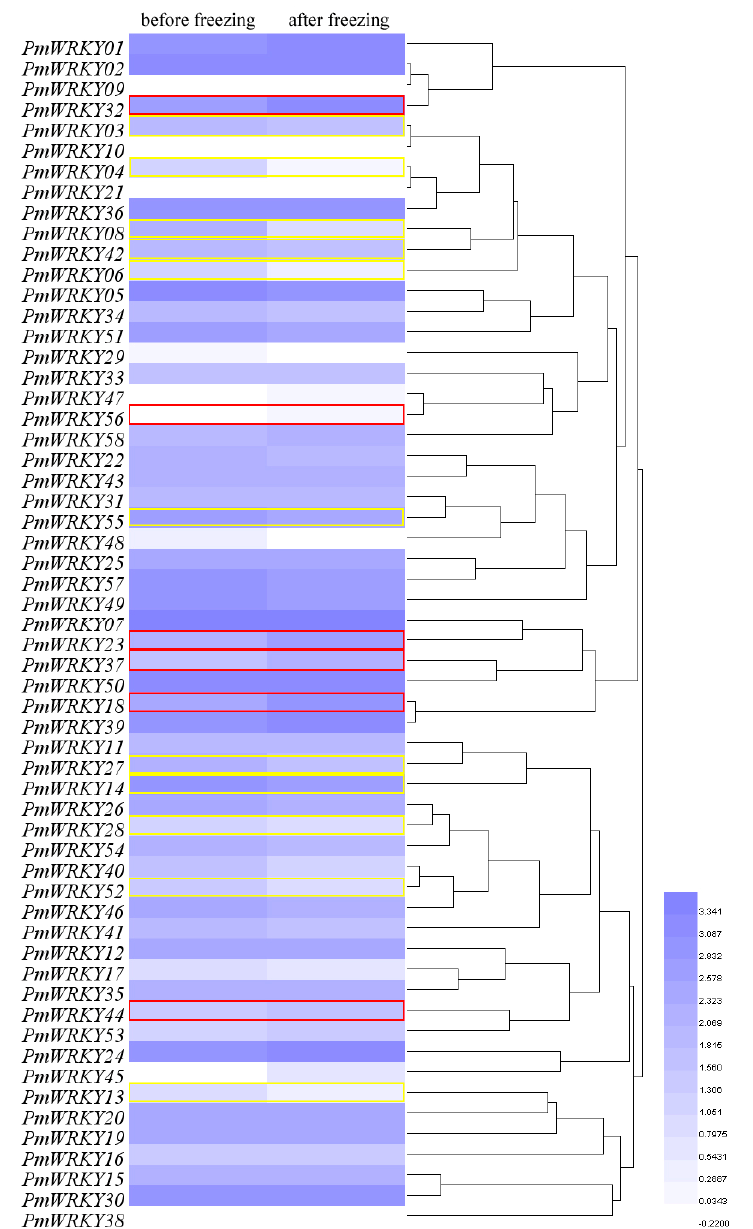
Figure 6. Hierarchical-clustering analysis of expression profiles of PmWRKYs in leaf buds of ‘Zhusha’ before and after freezing effect in winter. Transcriptome sequencing (RNA-seq) was performed to investigate expression profiles of PmWRKY genes. The colour scale represents RPKM expanded 25 times and then normalised log10 transformed counts. Light blue indicates low expression. Blue and dark blue indicate high expression. The genes which were up- or down-regulated over two fold were surrounded by red and yellow boxes, respectively.